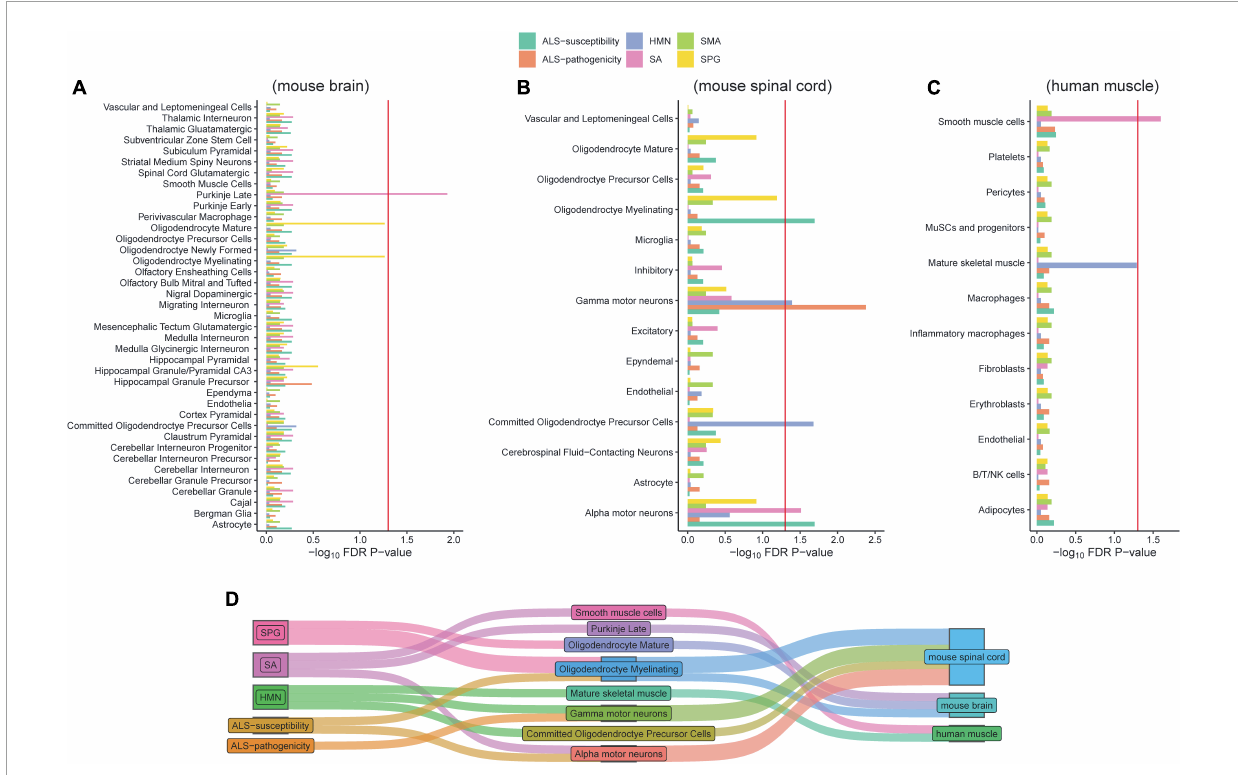
FIGURE2 Associations of cell types and six gene panels. The red line refers to the significance threshold ( P -adjusted < 0.05) after FDR adjustment. Histograms exceeding the red line indicate the cell types of mouse brain (A) , mouse spinal cord (B) , and human muscle (C) significantly associated with corresponding gene lists. The Sankey diagram linked the diseases and associated cell types (D)